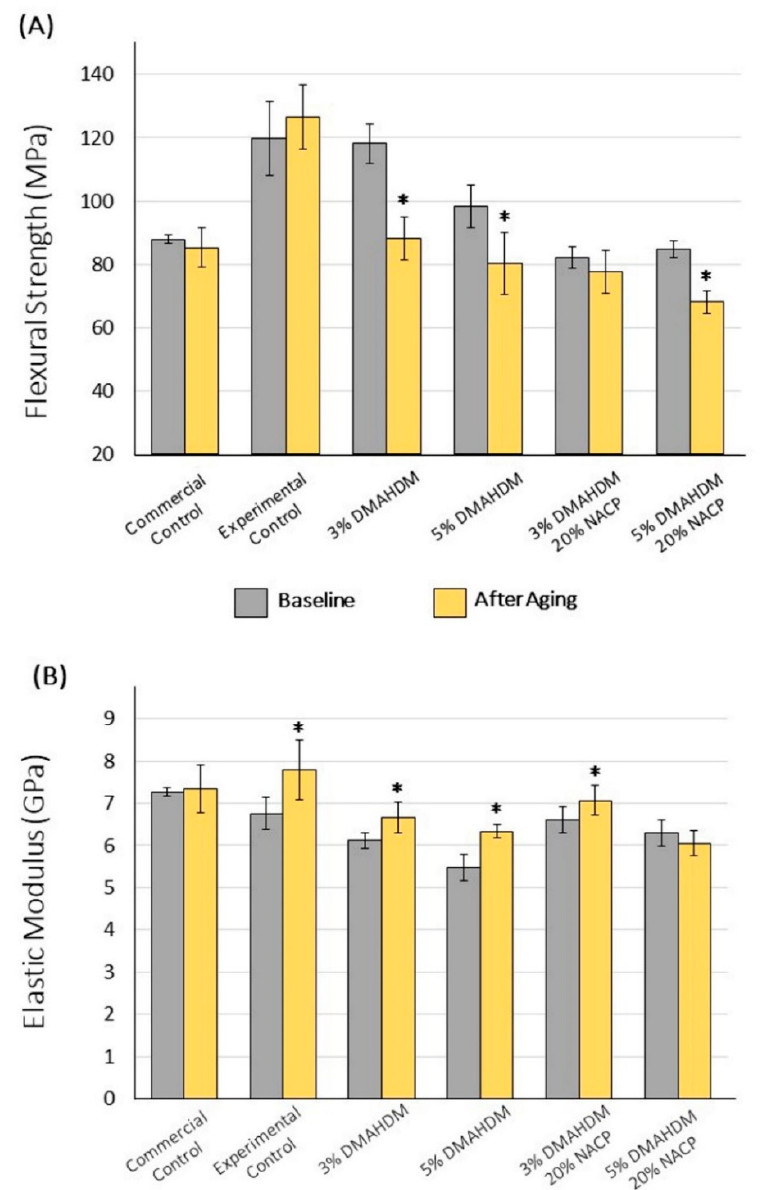
Figure 2. ( A ) The flexural strength values (mean ± SD; n = 6) of different composite formulations at baseline and after aging. ( B ) The elastic modulus values (mean ± SD; n = 6) in different composite formulations after aging and at baseline. * Asterisks indicate significant differences compared to baseline values before aging.